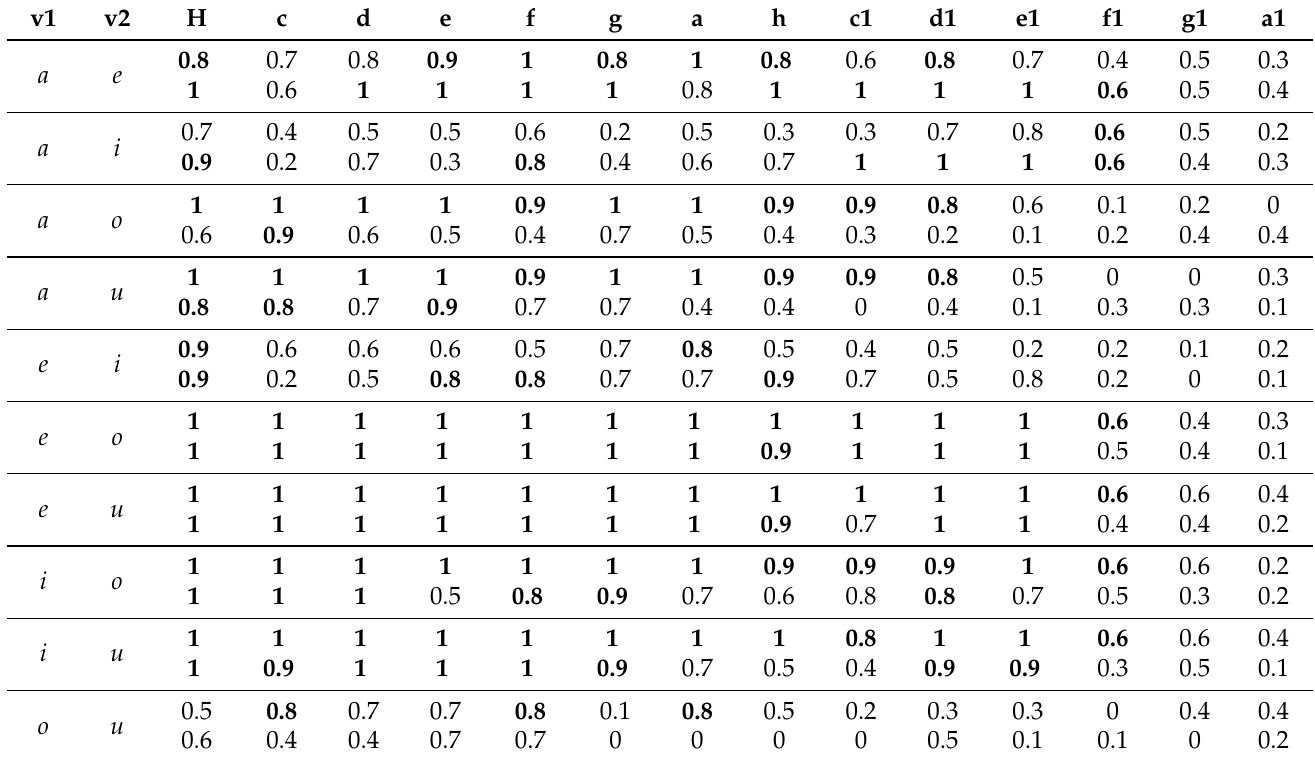
Table A3. Biserial correlation coefficients for the horizontal and vertical beamwidths at each pitch for the male singers (samples n H–e = 12, samples n f = 9). Horizontal and vertical biserial correlation 1 1 –a 1 coefficients are listed at the top and bottom in each cell. Bold letters indicate that there is a significant difference ( p > 0.05) between the vowel groups listed in the first and second column.